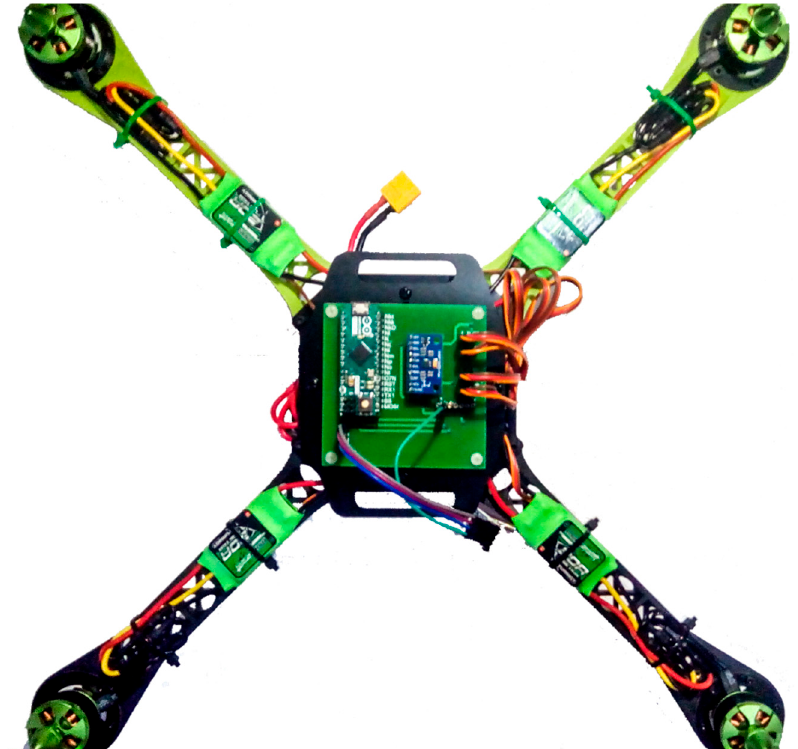
Figure 3. The unmaned aerial vehicle (UAV) prototype.